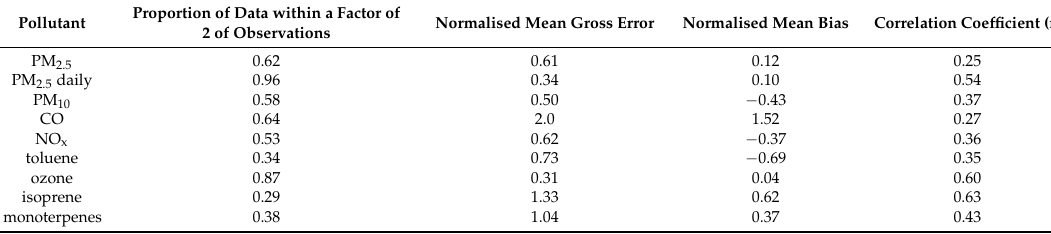
Table 3. Basic skill statistics for CSIRO Chemical Transport Model (C-CTM) 1 km x 1 km grid to point measurements of PM 10 and PM 2.5 at the NSW OEH Air Quality station at Wollongong, and measurements of CO, O 3 , NO X , toluene, isoprene and monoterpenes at the main MUMBA site. Data is hourly unless otherwise